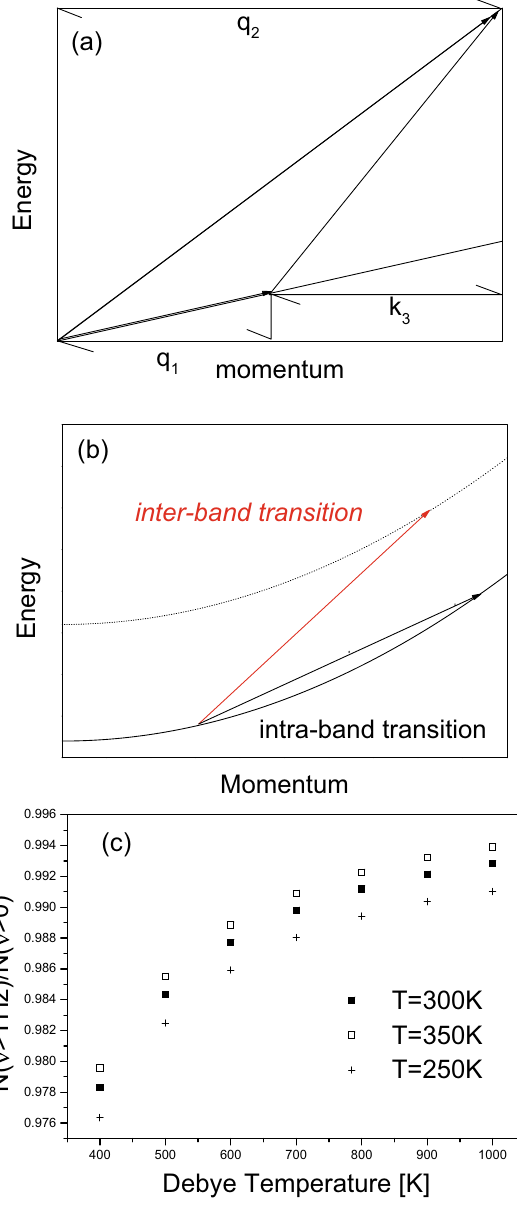
Figure 6. ( a ) A sketch illustrates that three waves with linear dispersion relation can form a closed energy– momentum conservation process. The slope of each straight-line segment represents its phase velocity. Because of c tr < c lo < c , q 2 = q 1 + k 3 and c lo q 2 = ω 2 = ω 1 + E k = c tr q 1 + ck 3 can be satisfied, where c lo and c tr are phonon’s phase velocities and c is light velocity. ( b ) A sketch illustrates that a transition between two electronic states k 4 , k 5 within a same parabolic band cannot ensure the momentum difference k 5 − k 4 = k 3 and the = const , which can be energy difference E 5 − E 4 = k 2 5 − k 2 4 to satisfy a linear dispersion relation E 5 − E 4 k 5 − k 4